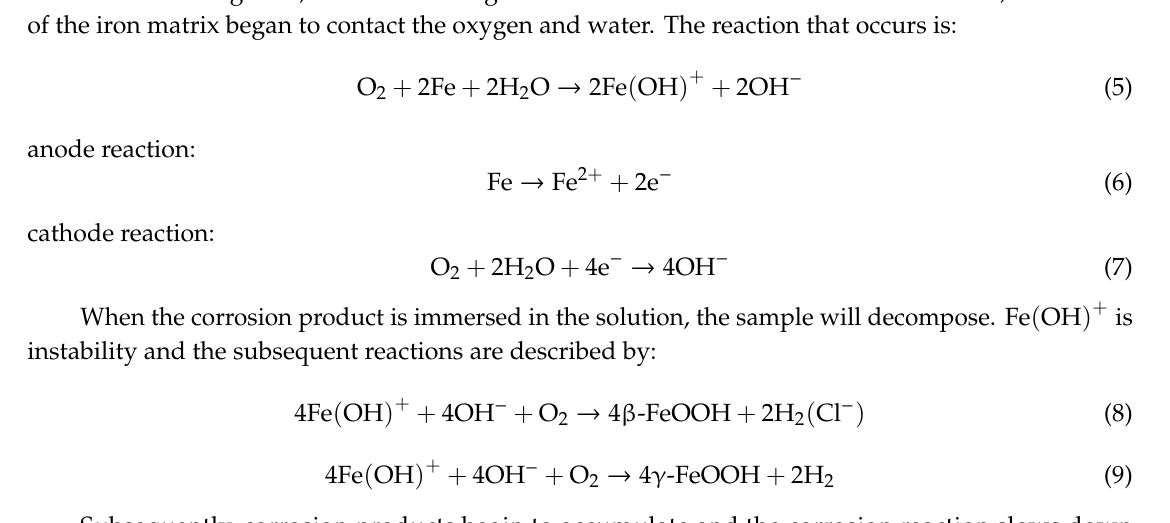
Figure 10. Relationship between Si content and resistance at 6th, 30th, 120th cycle.